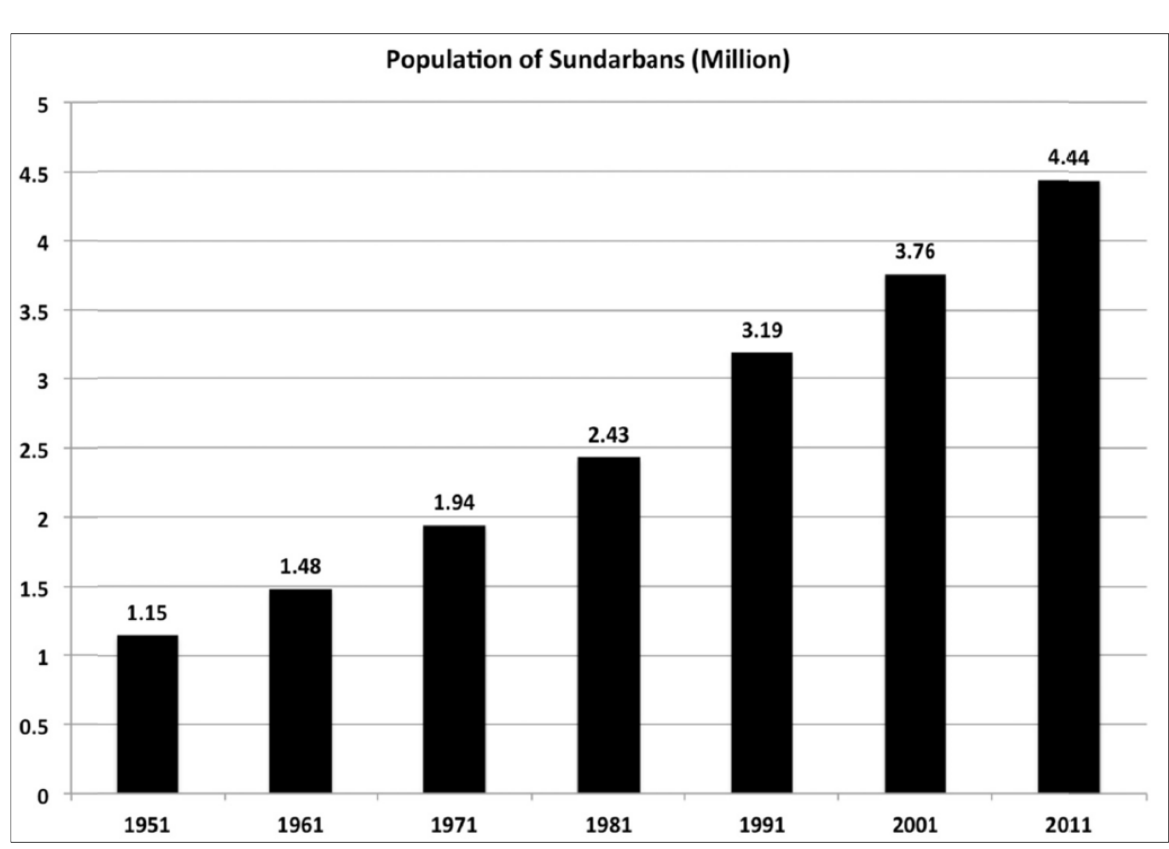
Figure 3. Human population growth in the Indian Sundarbans between 1951 and